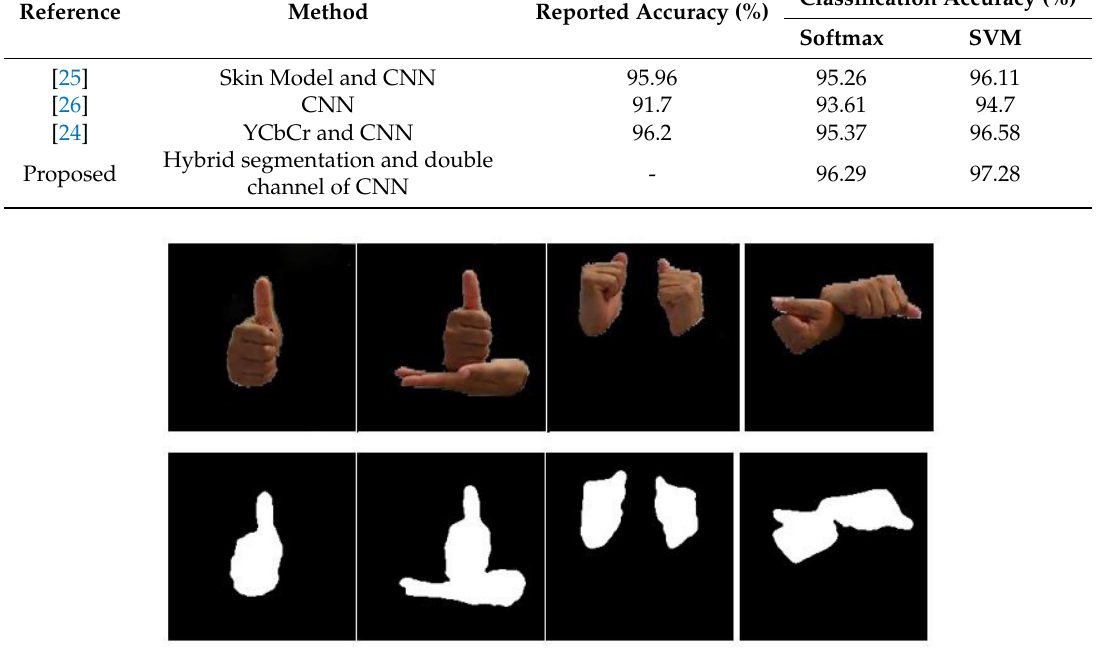
Figure 12. Misrecognized hand gestures.